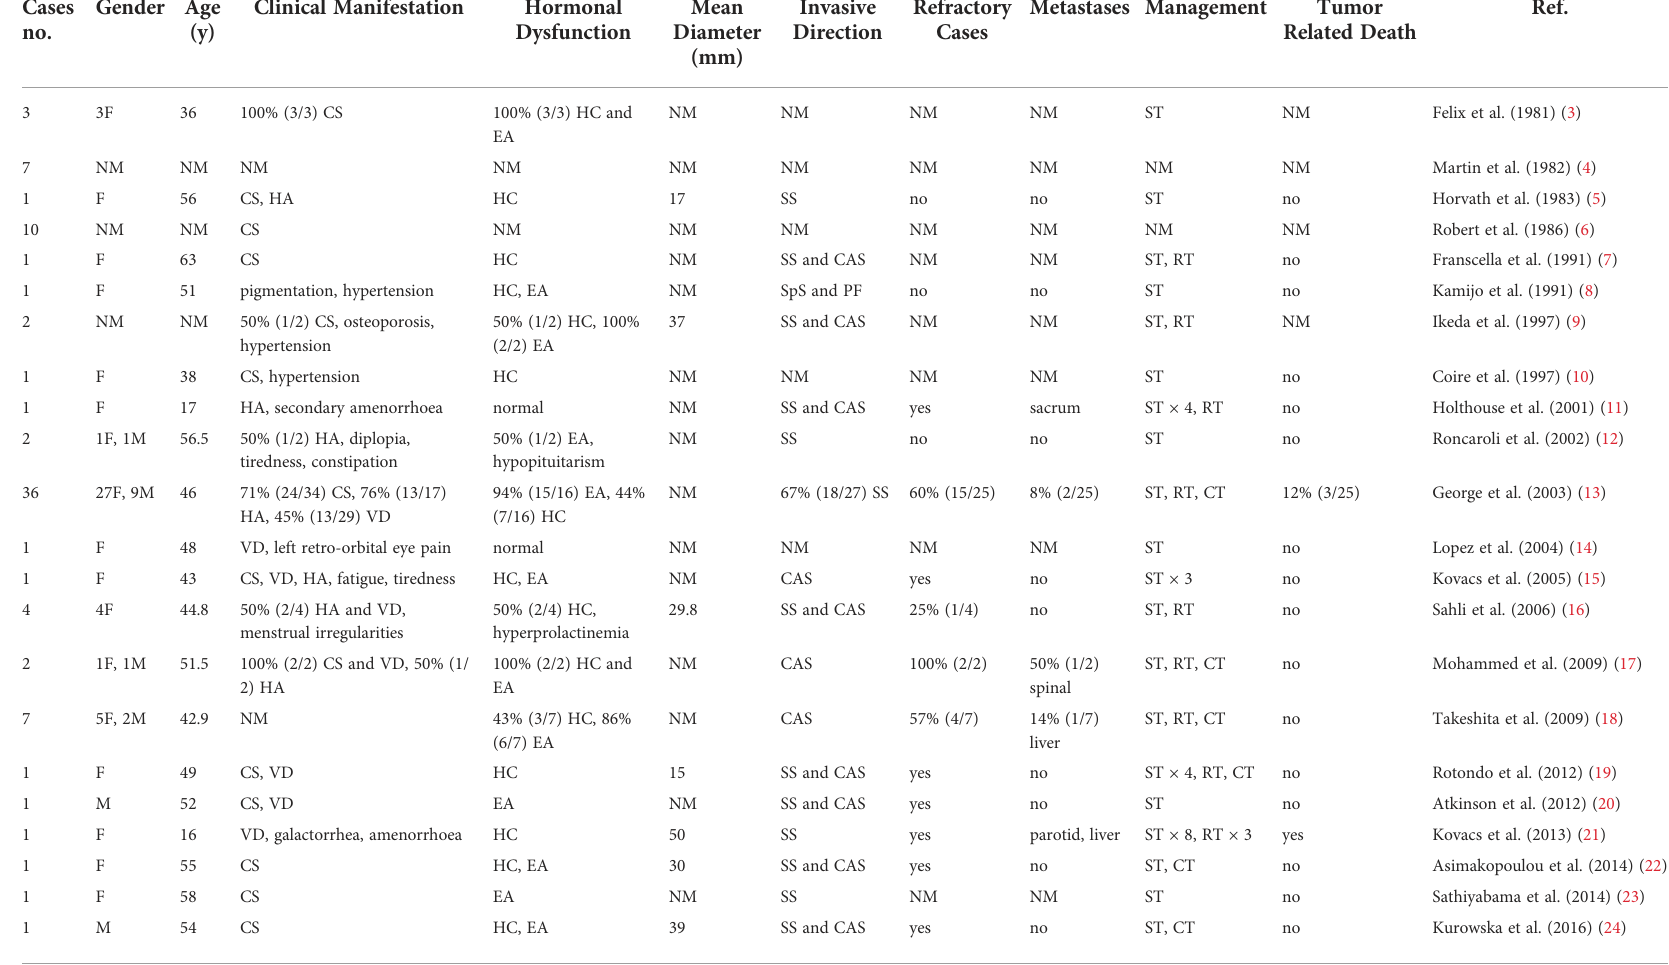
TABLE 3 Literature summary of Crooke ’ s cell adenomas. Cases